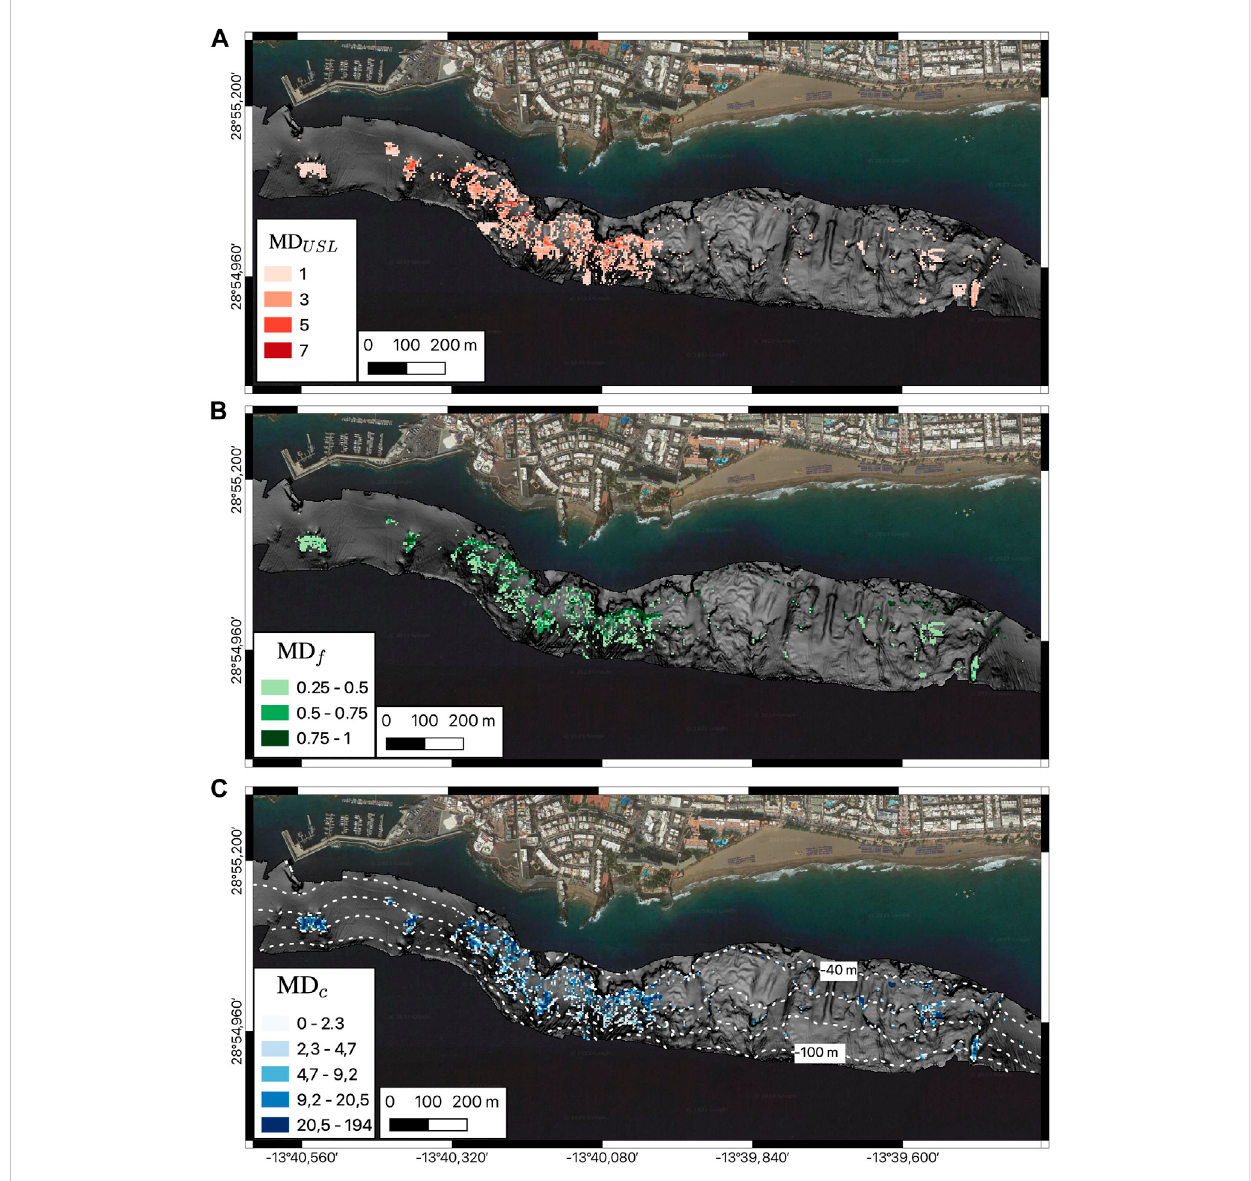
FIGURE 4 (A ) Grid of MD USL . (B) Grid of MD f . (C) Grid of MD c . Isobaths are displayed as white dashed